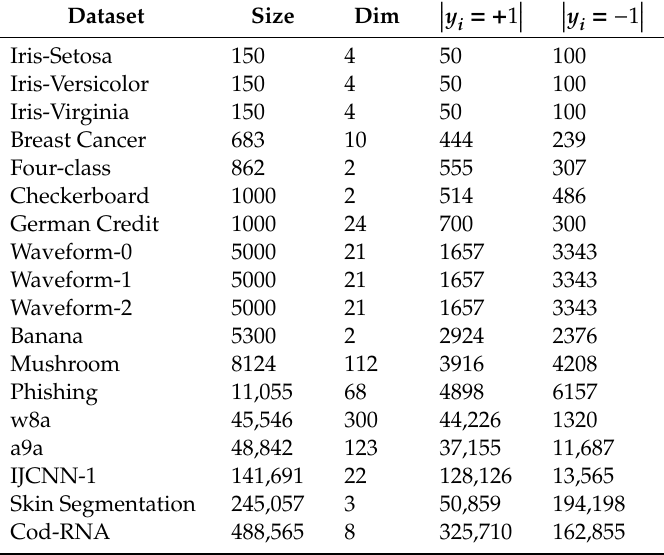
Table 2. Datasets for experiments.